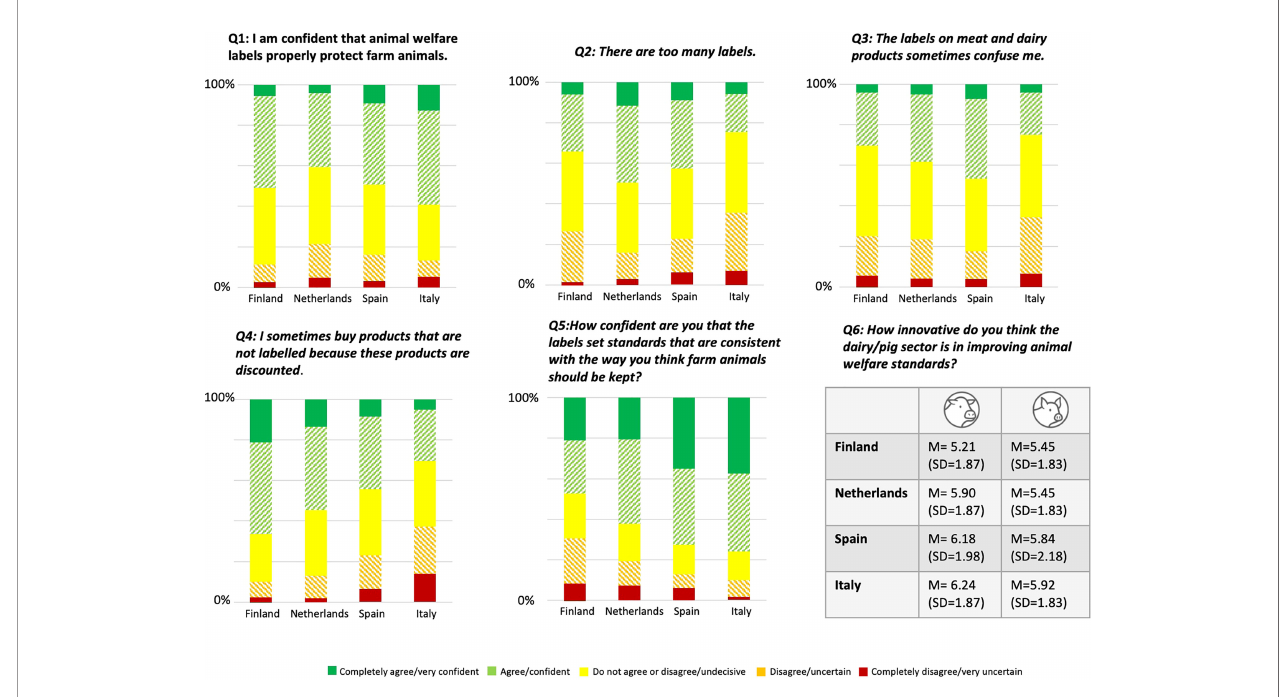
FIGURE 1 | National results of the consumer